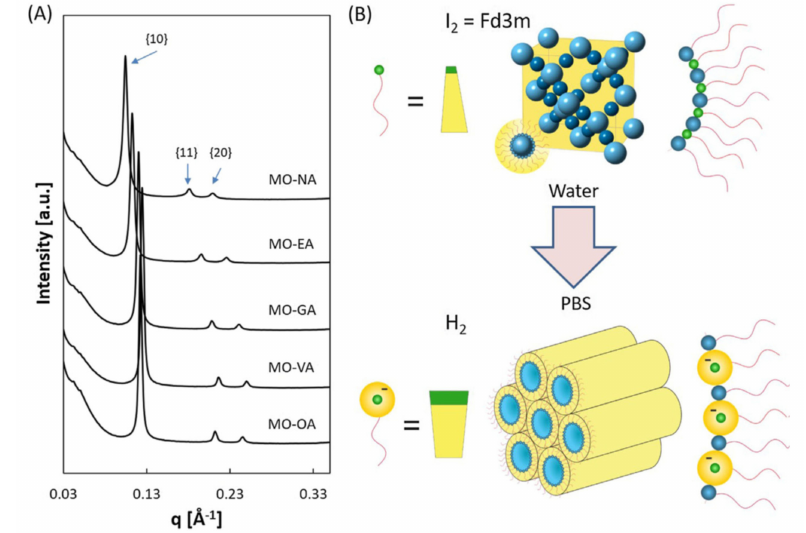
Figure 4. ( A ) SAXS patterns of monoolein (MO)-fatty acid nanoparticles exhibiting a hexagonal H II symmetry in bu ff er medium (PBS, pH 7.4) at 30 ◦ C. ( B ) Schematic presentation of the e ff ect of pH on the ionization state of the unsaturated fatty acid and the interfacial curvature leading to a transformation of the micellar cubic Fd3m phase into an inverted hexagonal H II phase when water is replaced by PBS (reproduced from [70], with permission from Elsevier, 2020).